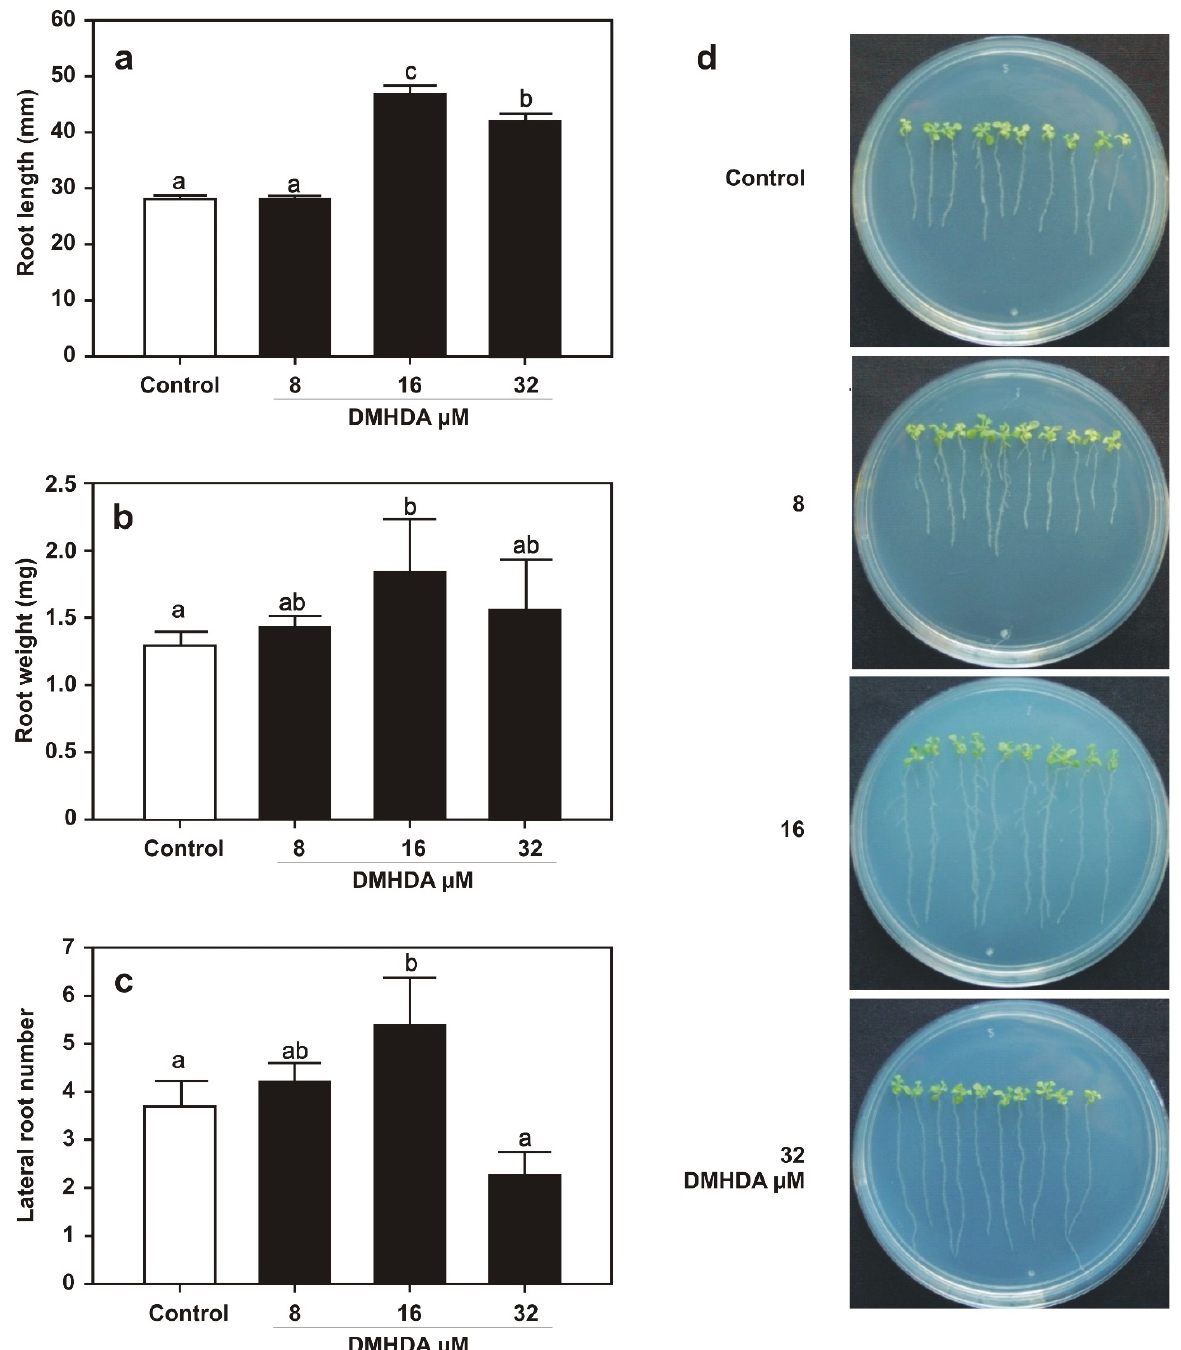
Figure 5. DMHDA induces long-lasting development effects in vitro in A. thaliana . A. thaliana seeds were sown in 0.2 × MS medium supplied with 0, 8, 16, and 32 µ M of DMHDA. After 72 h after germination, seedlings were transferred to 0.2 × MS DMHDA-free plates; after eight days, the morphometrical parameters were recorded: ( a ) root length, ( b ) root weight, and ( c ) lateral root number. Values represent the means of 40 replicates ± SE. Different letters represent means that are statistically different (Duncan ´ s test; p < 0.05). Panel ( d ) shows representative images of the experiment on DMHDA-free